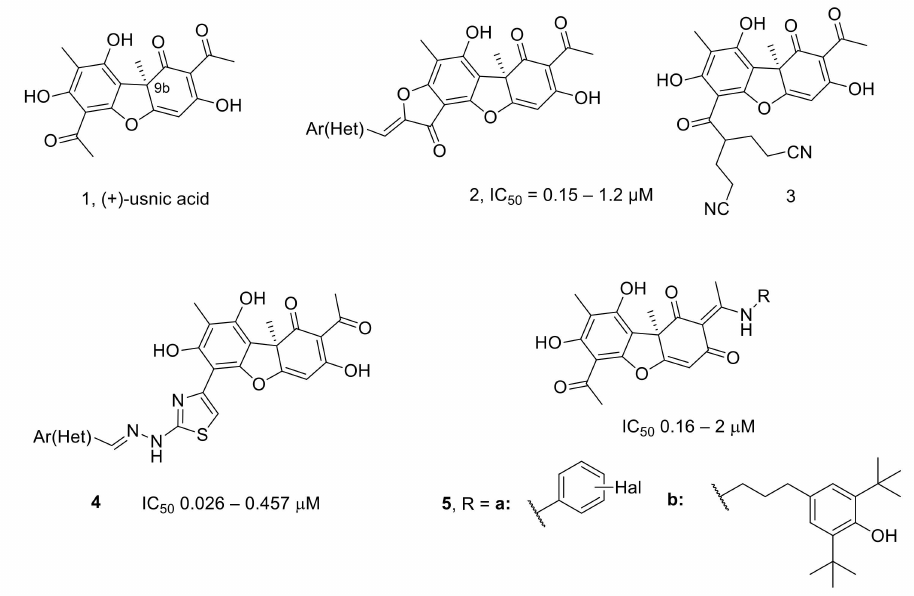
Figure 1. Structures of usnic acid ( 1 ) and its derivatives ( 2 – 5 ) that inhibit